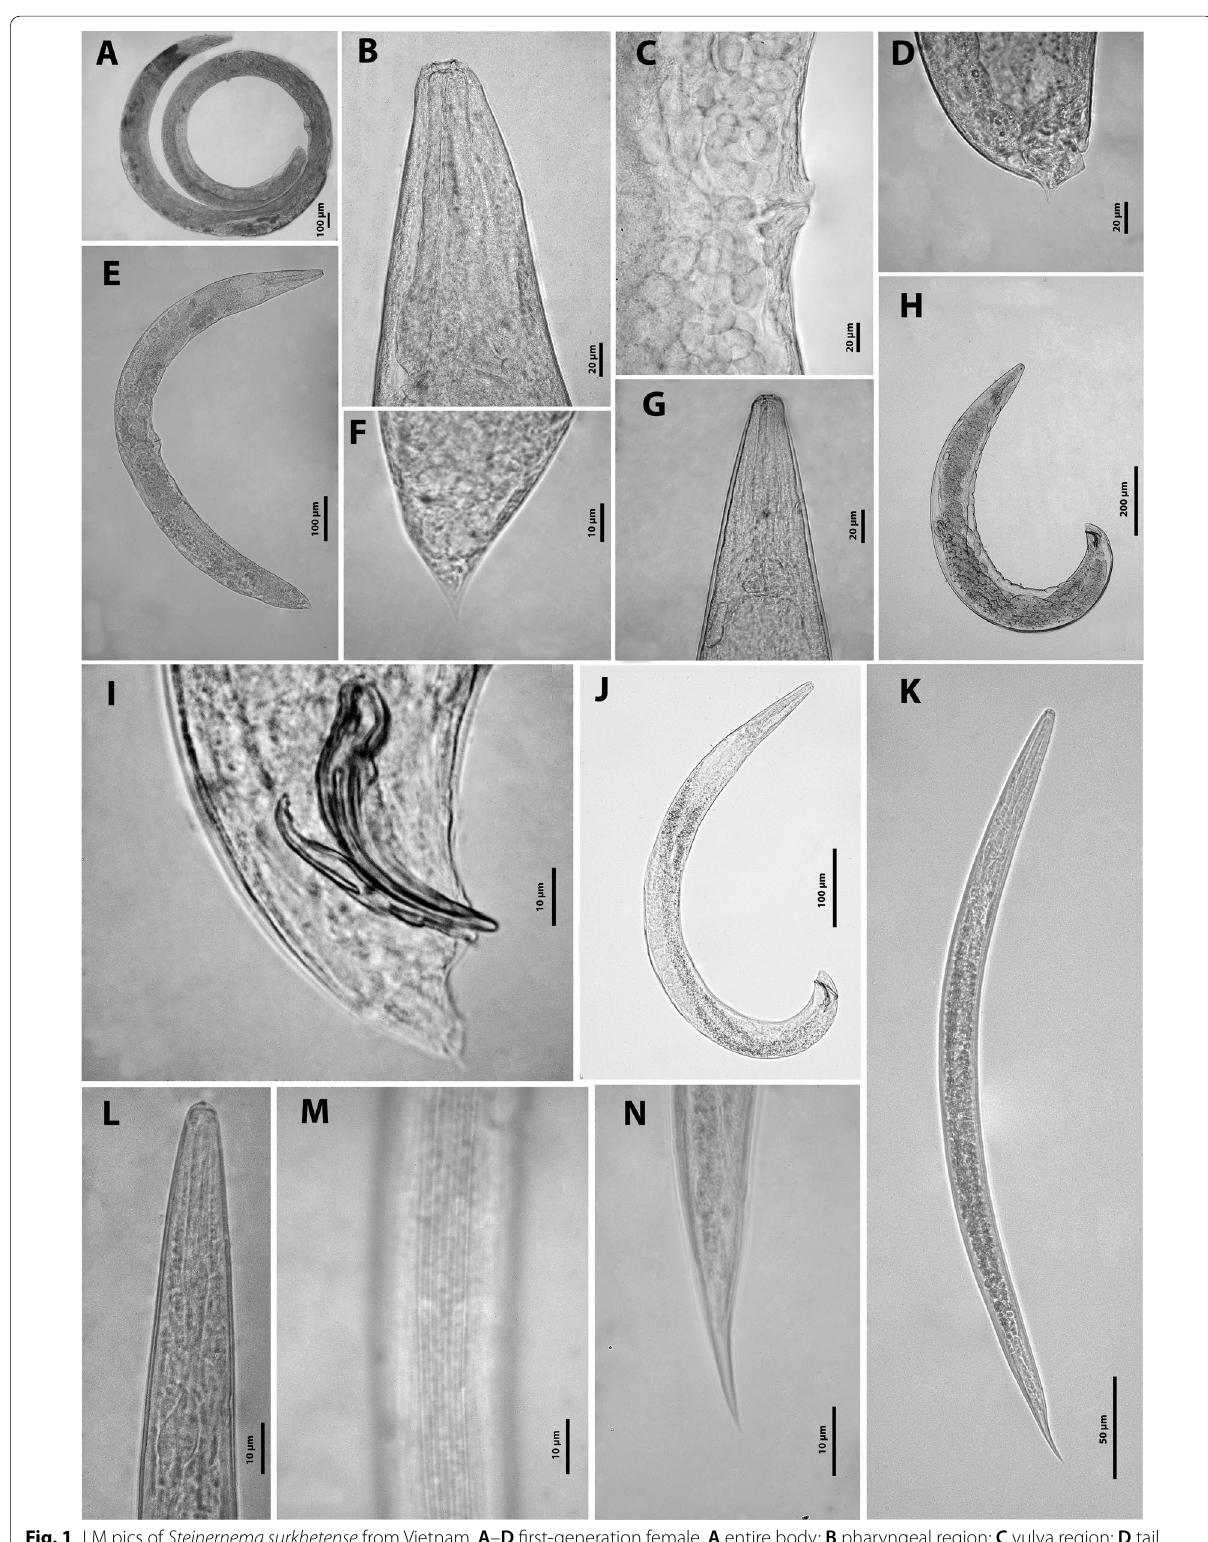
Fig. 1 LM pics of Steinernema surkhetense from Vietnam. A – D first-generation female. A entire body; B pharyngeal region; C vulva region; D tail region. E – F second-generation female. E entire body; F tail region. G – I first-generation male. G pharyngeal region; H entire body; I tail region. J entire body of second-generation male. K – N juvenile. K entire body; L pharyngeal region; M lateral field; N tail